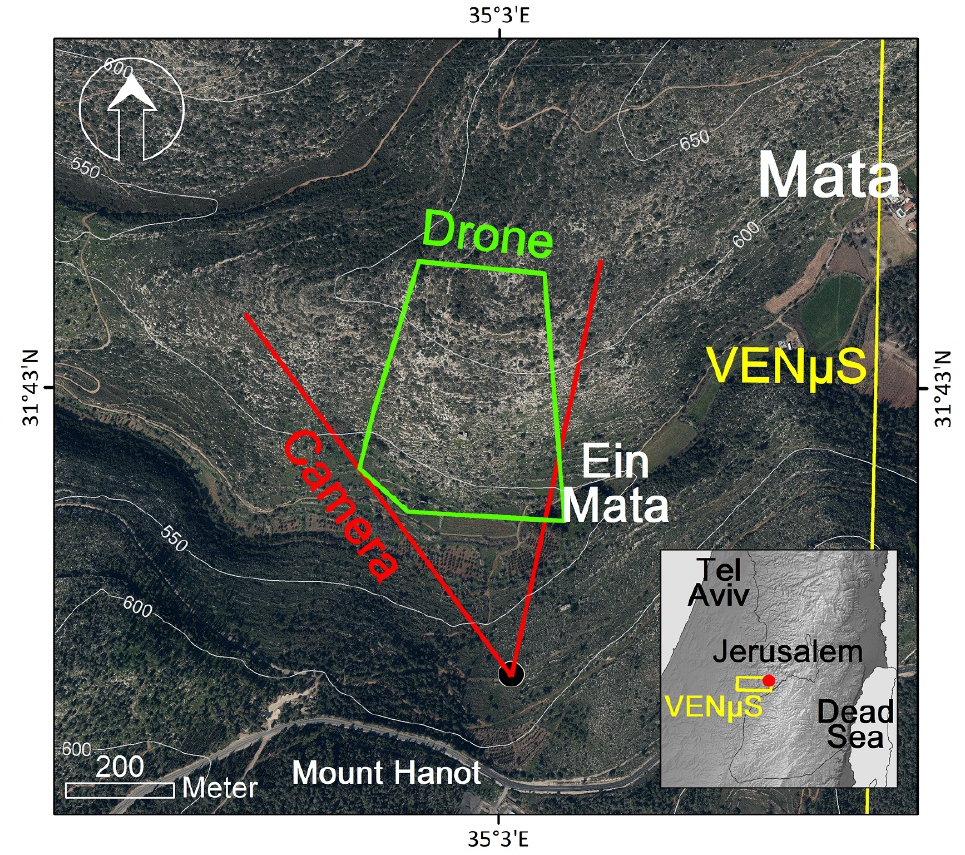
Figure 1. Mata research site overview map; red lines represent the field of view of the ground camera, with a black dot indicating the location of the camera; the green polygon represents the extent of the UAV mosaics; and the yellow polygon represents part of VEN μ S S01 tile (appearing in the inset map) which overlaps the research area.